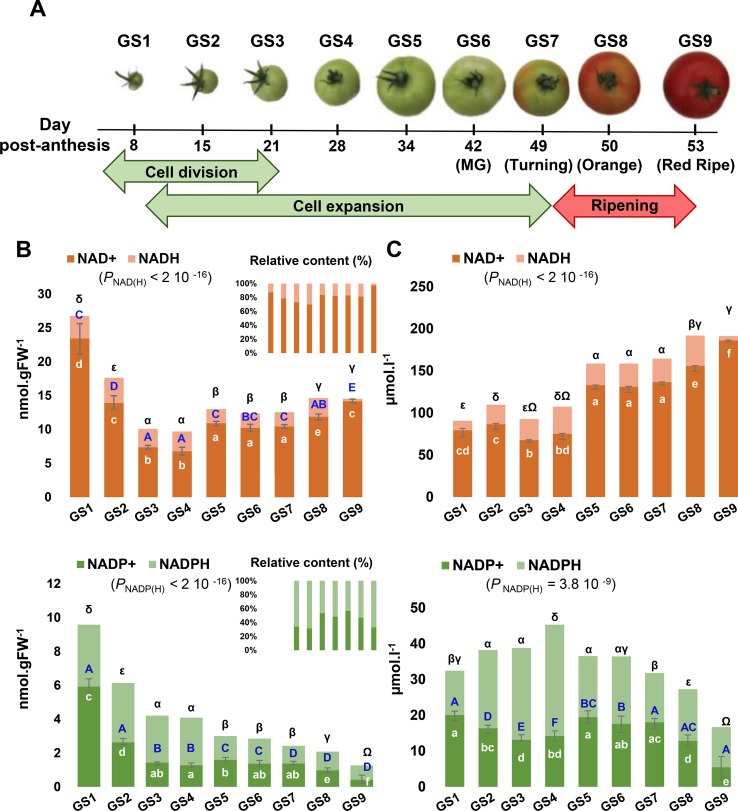
Evolution of NAD(P) contents during tomato fruit development. NAD and NADP pools were measured for nine sequential growth stages (GS) of tomato fruit development (A). Shown are bar plots of replicated metabolite quantifications (n = 3) (B) and of replicated metabolite quantifications (n = 3) normalized to the cytosol and organelles volumes (C). Top and bottom error bars indicate SEM (standard error of the mean) for the reduced and oxidized forms, respectively. Statistical significance for total NAD(P) content is indicated by ANOVA P value. Binary comparisons between conditions are indicated by letters (oxidized form, in white), capital letters (reduced form, in blue), and symbols (total content, in black), according to Student’s t test (P < 0.05). Left panel indicates the concentrations of NAD(P) in nmol.gFW−1 whereas the right panel indicates the NAD(P) concentrations in µmol.l−1.